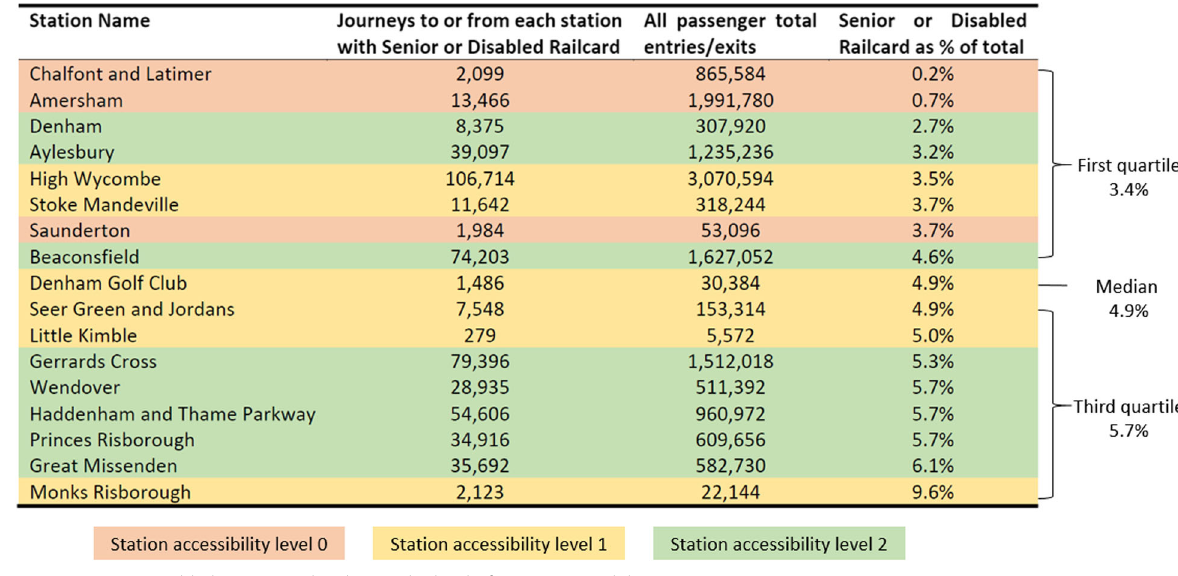
Fig. 6 Senior or Disabled Persons Railcard usage by level of station